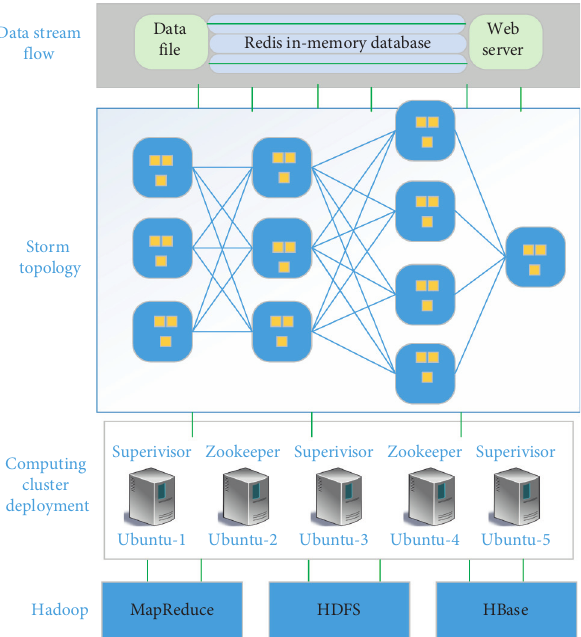
Figure 3: Architecture of the industrial heritage cloud platform based on Hadoop